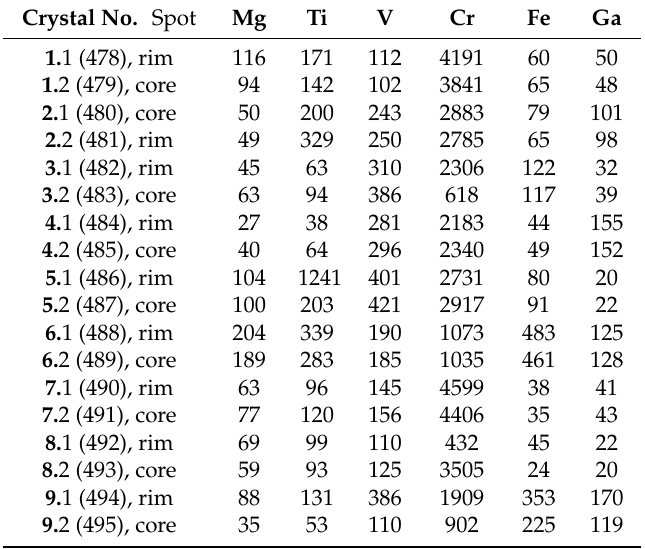
Table A1. LA-ICP-MS trace element values (ppm) 1 , Thurein Taung ruby. Crystal No. Spot